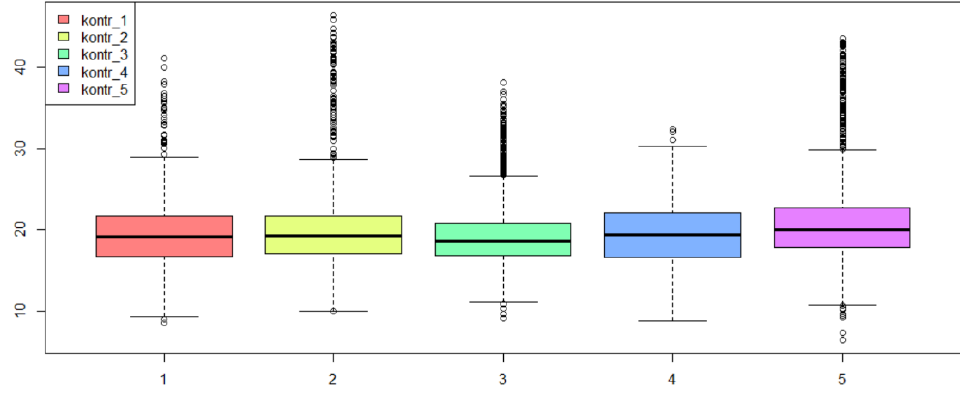
Figure 10. Temperature by contractor.